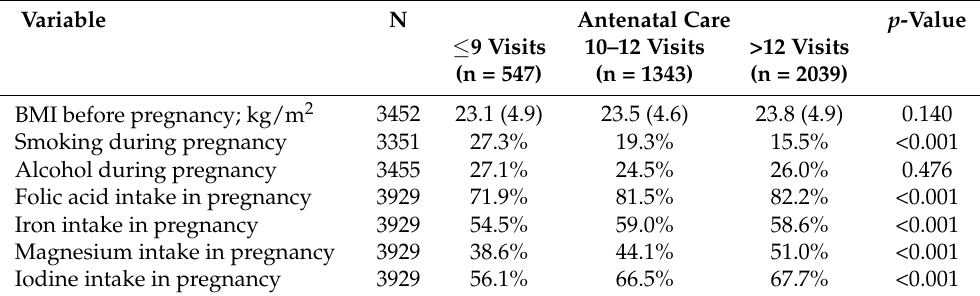
Table 3. Selected health behavior in relation to participation in medical check-up during pregnancy in the SNiP-I cohort from 2004 to